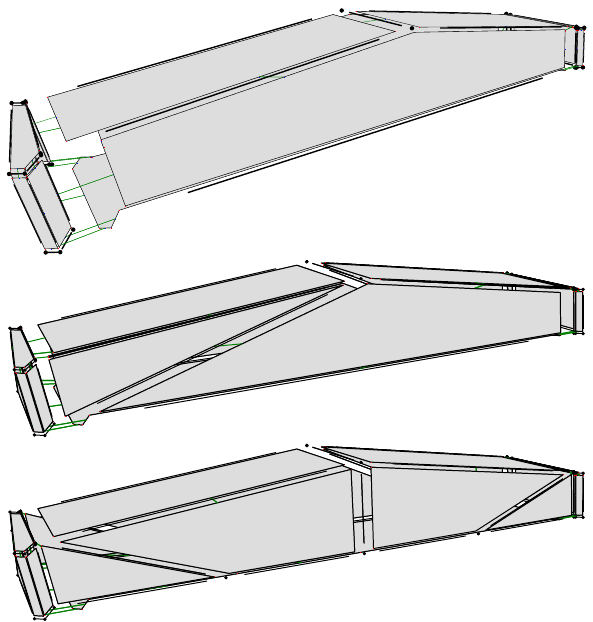
Figure 5. The intermediate volume between the roofs of two models. The volume is created after the darts have been associated with each other according to the simple-linking (top), collapse to closest (middle) and topology modification (bottom)